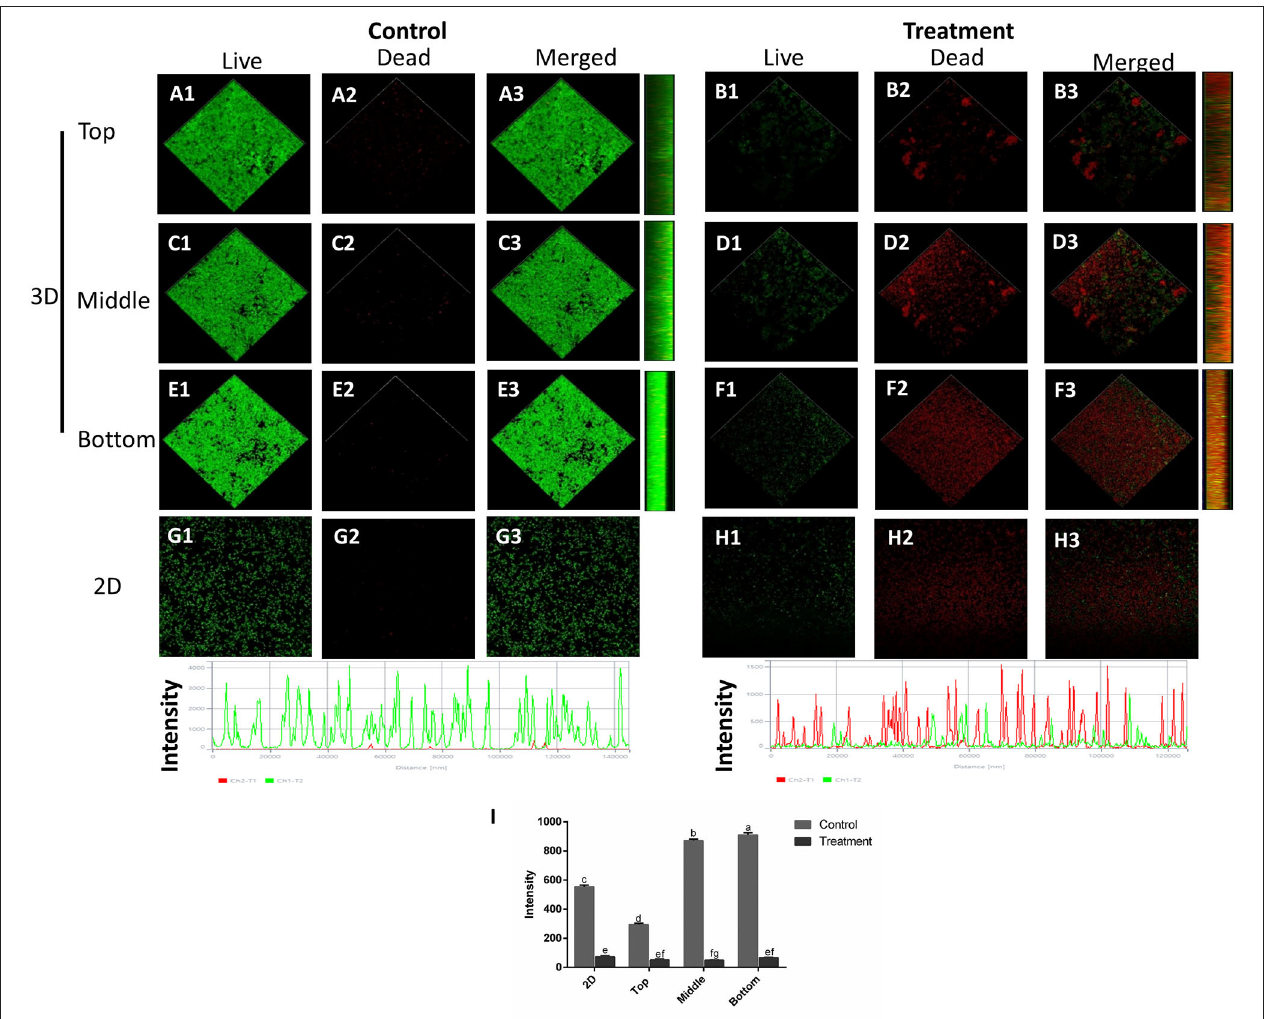
FIGURE 6 | Confocal laser scanning microscopy images of the changes in the spatial structures of S. aureus and L. monocytogenes Scott A mixed-species biofilms under SAEW treatment (Scale bar = 120 µ m). (A) (top image of control mixed-species biofilms), (C) (middle image of control mixed-species biofilms), (E) (bottom image of control mixed-species biofilms), (B) (top image of treatment mixed-species biofilms), (D) (middle image of treatment mixed-species biofilms), (F) (bottom image of control mixed-species biofilms), (G) (2D image of control biofilms), (H) (2D image of control biofilms), and (I) intensity. Different letters represent significant difference ( p <